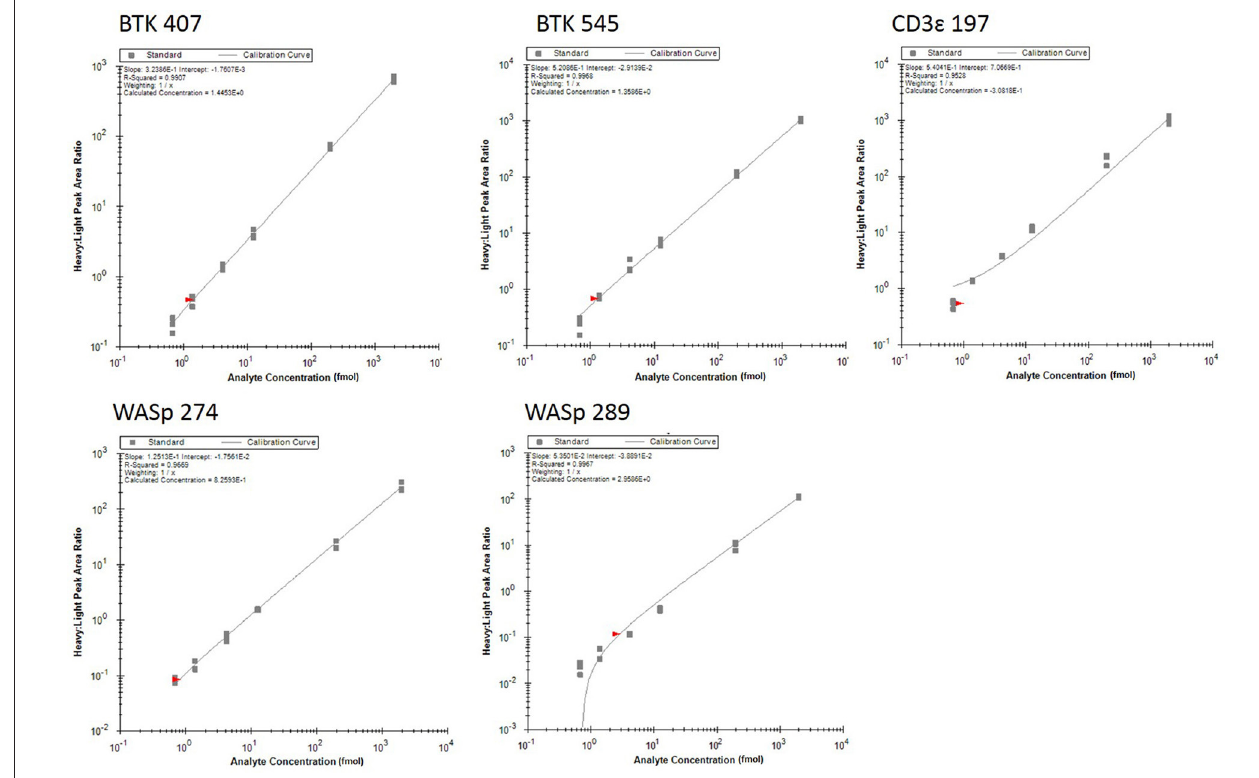
FIGURE 1 | Response curves for peptides measured by the multiplexed immuno-SRM assay. Response curves plot the heavy: light peak area ratio as a function of heavy peptide concentration, measured in a background matrix of digested protein extracted from dried blood spots. The curves allow determination of the linear range and sensitivity of the assay. Each data point is plotted as a gray box and linear regression is plotted as a line. Regression fit parameters are reported in the corner of each plot.